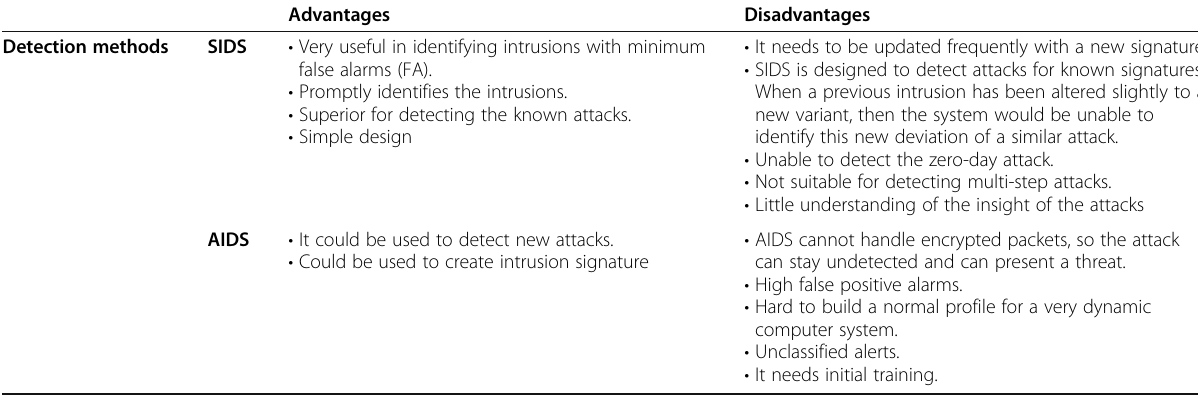
Table 2 Comparisons of intrusion detection